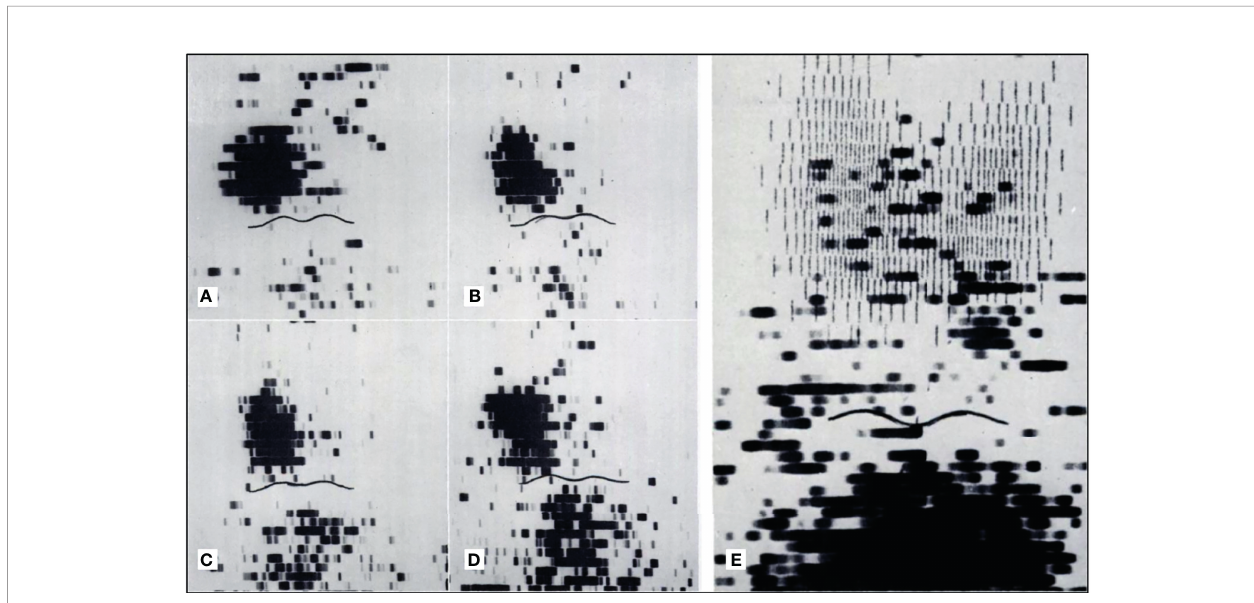
FIGURE 2 | Early parathyroid scintigraphy using 75 Se depicting a 2.3g parathyroid adenoma on the right. (A, B) 10 and 45 minutes after intravenous administration of radiotracer with tumor tracer localization and low tracer activity in the sternal region. (C, D) 2 h and 24 h after radiotracer administration with tumor tracer localization and increasing radiotracer activity in the sternal region. (E) Superimposition of thyroid scan onto parathyroid scintigraphy with 2.7 g parathyroid adenoma inferior to the left lobe of the thyroid. Reproduced with permission from: Colella AC, Pigorini F. Experience with parathyroid scintigraphy. Am J Roentgenol Radium Ther Nucl Med. 1970 Aug;109(4):714-23. doi: 10.2214/ajr.109.4.714. PMID: 5451873